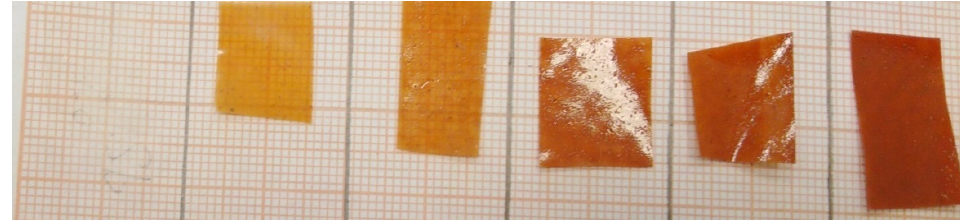
Figure 1. The color gradient of samples with increasing MZFA concentrations. Pure PVA: PVA + 2%MZFA PVA + 4%MZFA PVA + 6%MZFA PVA + 8%MZFA PVA + 10%MZFA.